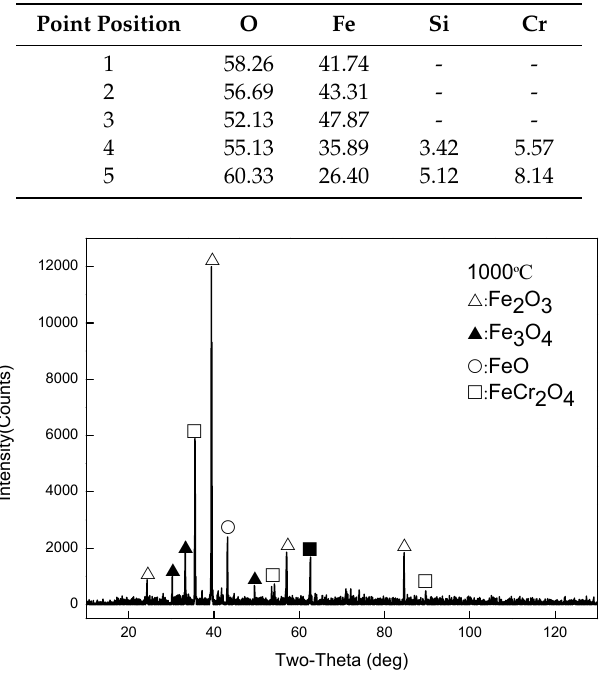
Figure 9. XRD data for the oxide scales obtained at 1000 °C.